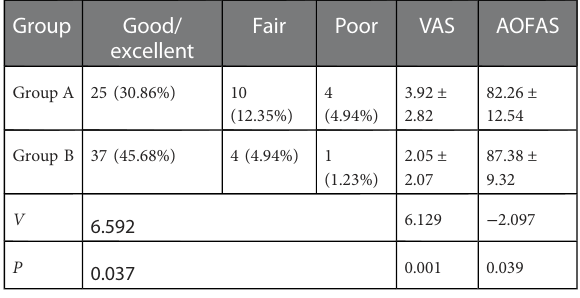
TABLE 2 Comparison of the two groups at the last follow-up.